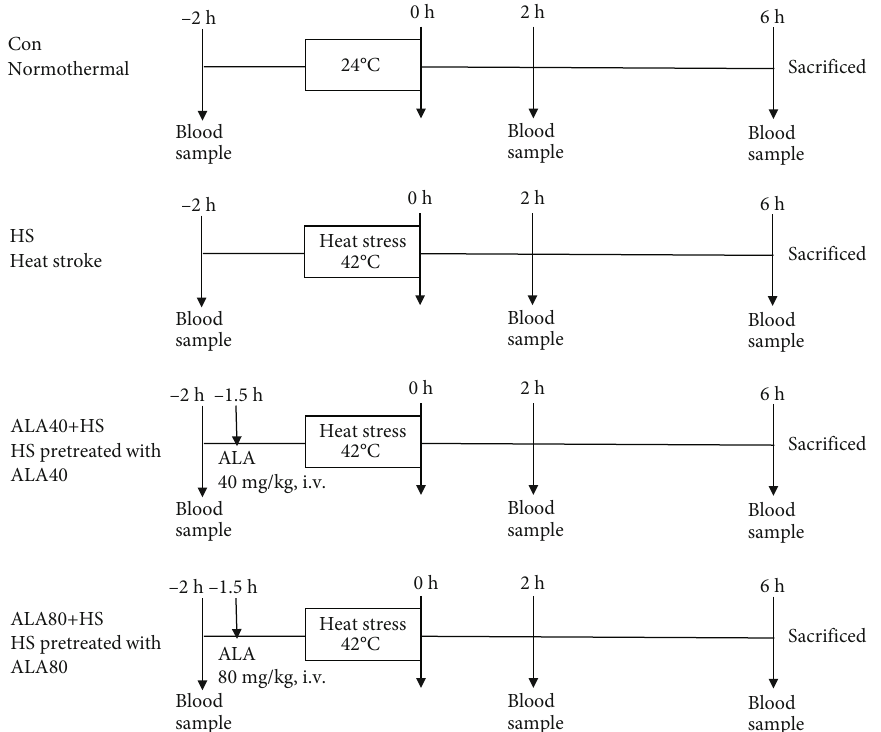
Figure 1: Experimental protocol. Con: normothermal control; HS: heat stroke; ALA40+HS: α -lipoic acid (40 mg/kg, i.p.) was administered 90min before heat stroke induction; ALA80+HS: α -lipoic acid (80 mg/kg, i.p.) was administered 1.5h before heat stroke induction.